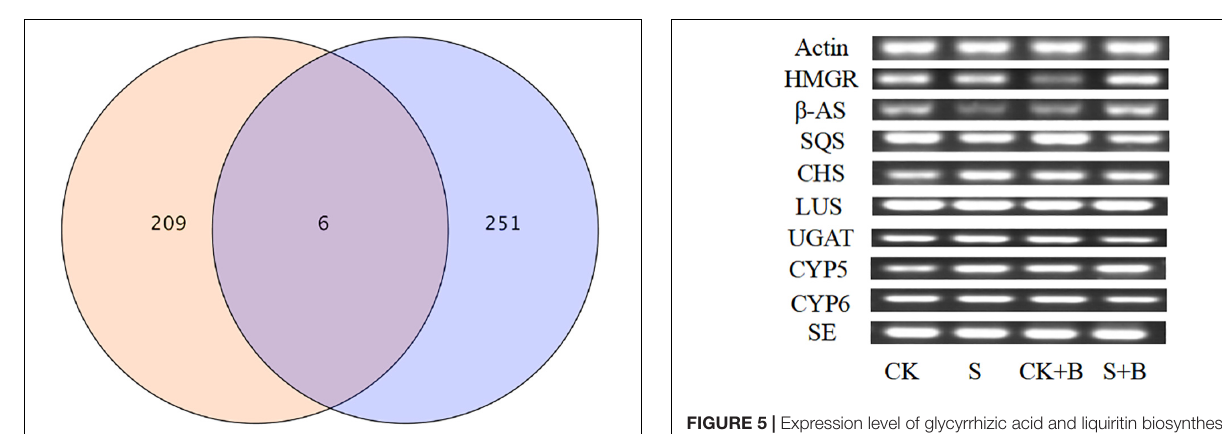
FIGURE 5 | Expression level of glycyrrhizic acid and liquiritin biosynthesis pathway-related genes in G. uralensis seedlings under control (CK), salt stress (S), control condition combined with B. cereus (CK + B), and salt stress combined with B. cereus (S + B).